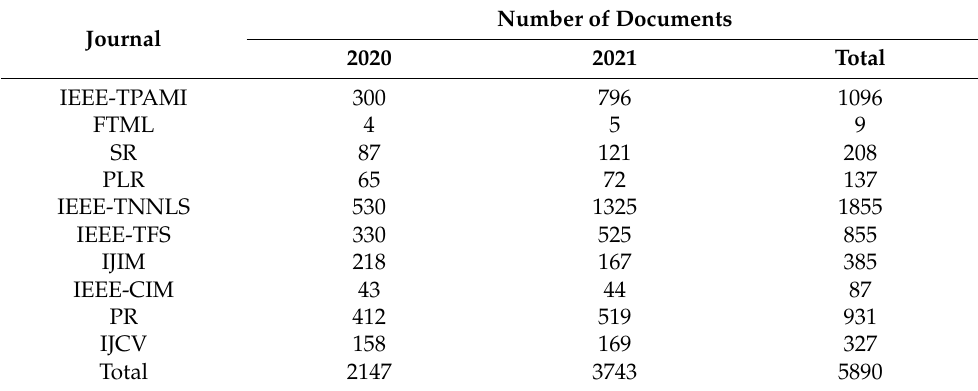
Table 2. Scientific production of the leading AI academic journals during 2020 and